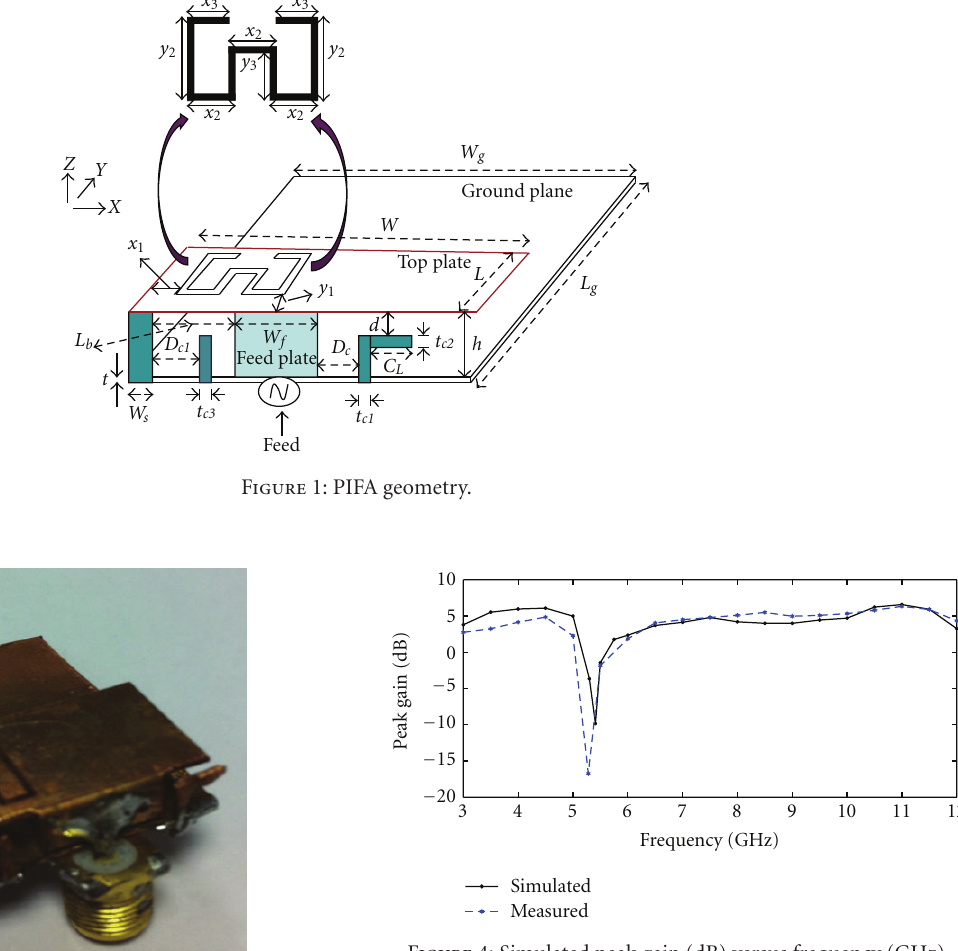
Figure 4: Simulated peak gain (dB) versus frequency